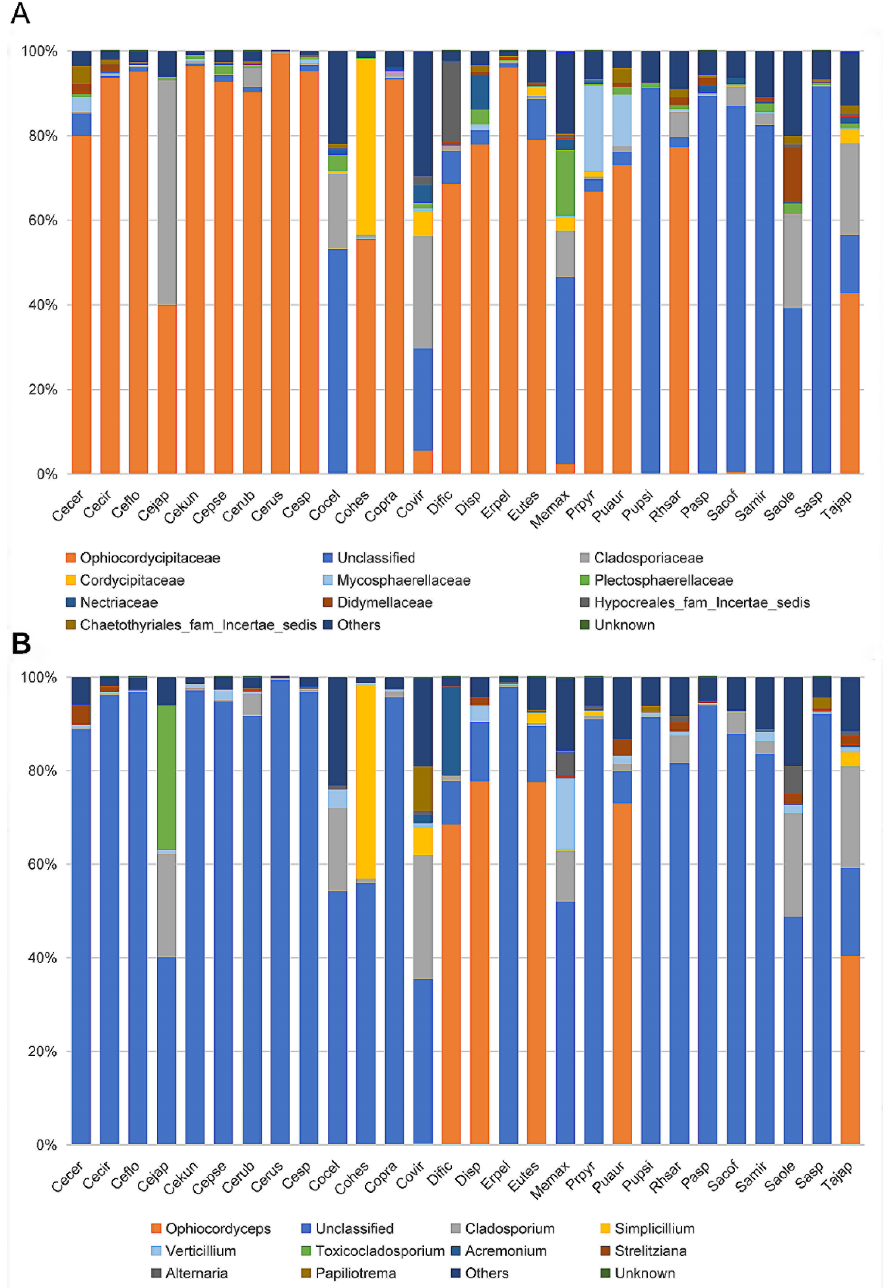
Figure 3. Relative abundance of fungi in 28 Coccidae species at family ( A ) and genus ( B ) levels as assessed by high-throughput amplicon sequencing of the internal transcribed spacer (ITS) gene. Ceroplastes ceriferus (Cecer, 1), Ceroplastes cirripediformis (Cecir, 3), Ceroplastes, floridensis (Ceflo, 4), Ceroplastes japonicus (Cejap, 1), Ceroplastes kunmingensis (Cekun, 1), Ceroplastes pseudoceriferus (Cepse, 3), Ceroplastes rubens (Cerub, 4), Ceroplastes rusci (Cerus, 1), Ceroplastes sp. (Cesp, 3), Coccus celatus (Cocel, 1), Coccus hesperidum (Cohes, 1), Coccus praetermissus (Copra, 1), Coccus viridis (Covir, 3), Dicyphococcus ficicola (Dific, 3), Dicyphococcus sp. (Disp, 1), Ericerus pela (Erpel, 3), Eucalymnatus tessellatus (Eutes, 3), Megapulvinaria maxima (Memax, 1), protopulvinaria pyriformis (Prpyr, 3), Pulvinaria aurantii (Puaur, 1), Pulvinaria psidii (Pupsi, 1), Rhodococcus sariuoni (Rhsar, 1), Parasaissetia sp. (Pasp, 4), Saissetia coffeae (Sacof, 2), Saissetia miranda (Samir, 2), Saissetia oleae (Saole, 1), Saissetia sp. (Sasp, 5), Takahashia japonica (Tajap, 3). The number in the bracket represents the sample number of each